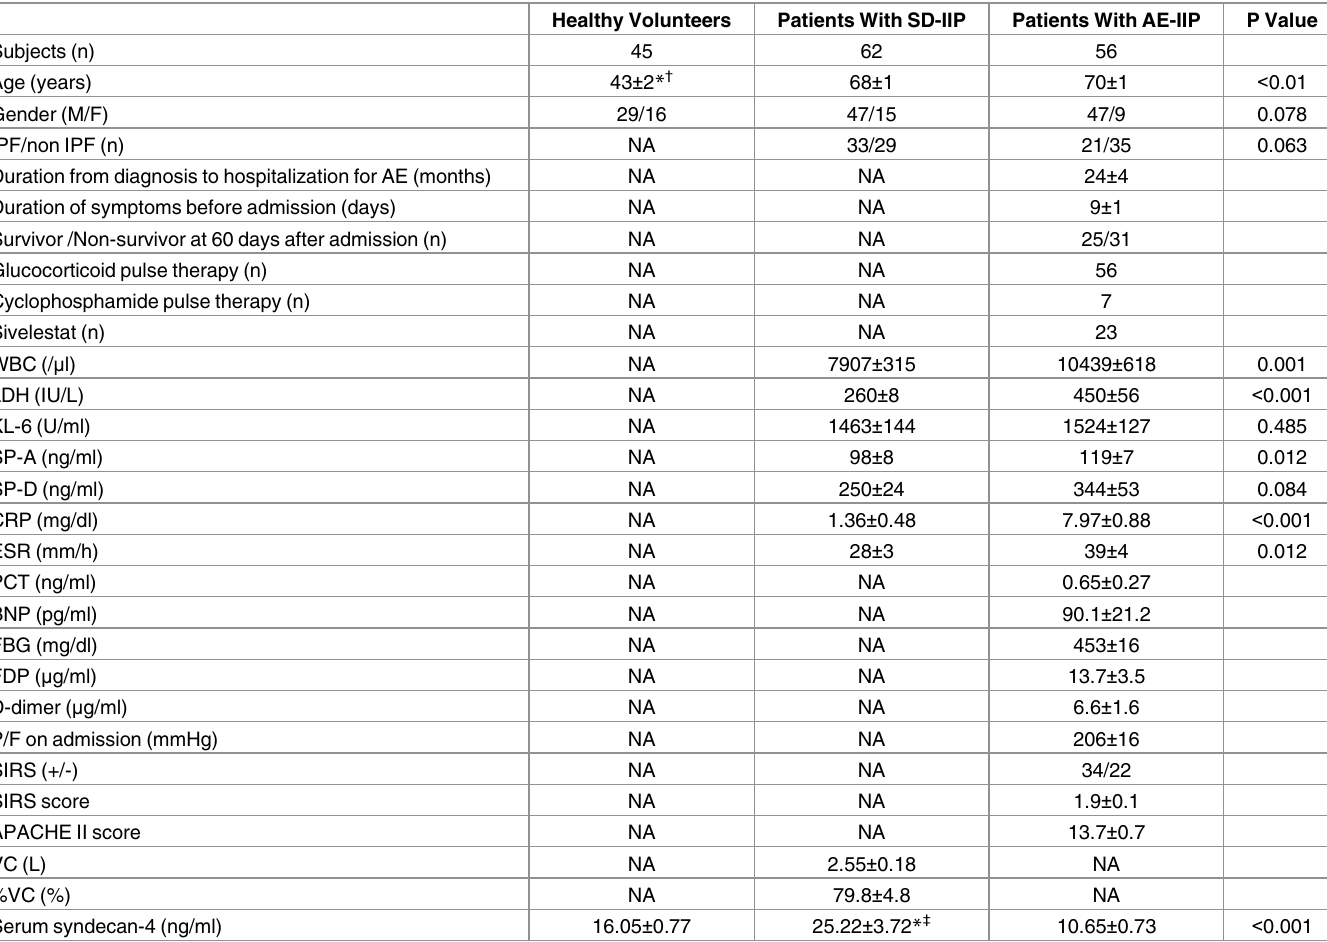
Table 1. Clinical characteristics of healthy volunteers, patients with AE-IIP, and patients with SD-IIP. Healthy Volunteers Patients With